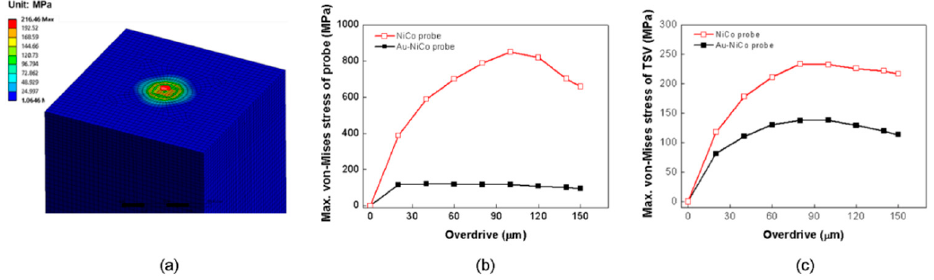
Figure 12. ( a ) The von Mises stress distribution generated in the Cu via of the TSV structure. ( b ) The variation in the maximum stress generated in the Cu via with increasing overdrive. ( c ) The variation in the maximum stress generated in the probe with increasing overdrive.